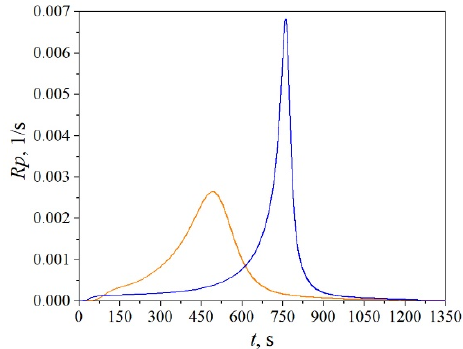
Figure 2. Kinetic curves of polymerization of bone cement composition (orange line) and mono- mers mixture (blue line) containing 0.5 wt.% of DMA co-initiator and 0.1 wt.% of BPO initiator as a mixture (blue line) containing 0.1 wt.% of BPO initiator and 0.5 wt.% of DMA co-initiator as a function function of polymerization rate ( R p ) from reaction time ( t ). of polymerization rate ( R p ) from reaction time ( t ).